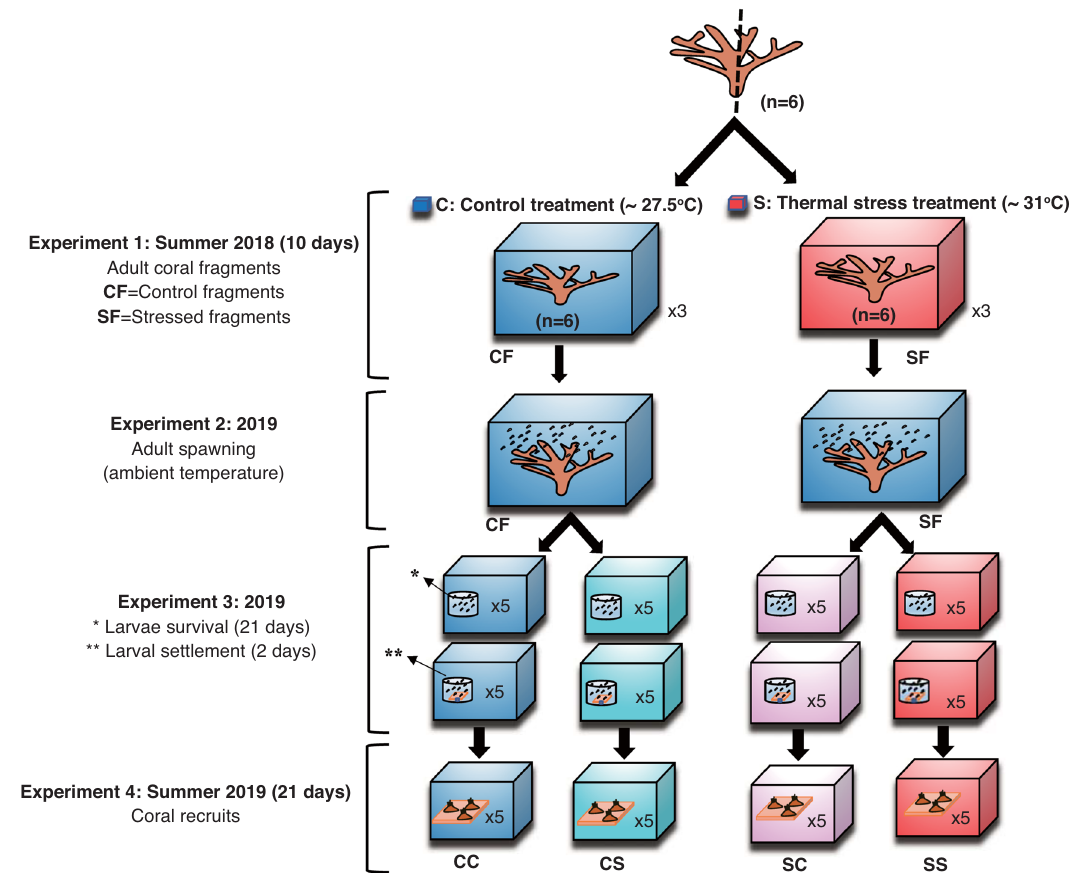
Fig. 1 Experimental design to examine the carryover effects of thermal stress on fecundity in adults and thermal tolerance in larvae and recruits of Acropora tenuis . Six colonies of Acropora tenuis were sectioned into two fragments and divided into two groups. The fragments were exposed to two temperature treatments: 1. thermal stress at ~31.2 °C (red aquariums containing stress fragments); and 2. control temperature at ~27.5 °C (blue aquariums containing control fragments). The four experiments were as follows: Experiment 1. The stress treatment group (SF) was exposed to thermal stress for 10 days. The Control group (CF) was also reared in the control condition for 10 days. Experiment 2. Effects of thermal stress on fecundity in adult corals. Experiment 3. Effects of thermal stress on the larval stage and larval settlement. Experiment 4. Effects of thermal stress on recruits obtained from stressed and control fragments. CC indicates larvae or recruits from the control fragments (CF) in the control condition, CS is larvae or recruits from CF in the stressed condition, SC is larvae or recruits from the stressed fragments (SF) in the control condition, and SS is larvae or recruits from SF in the stressed